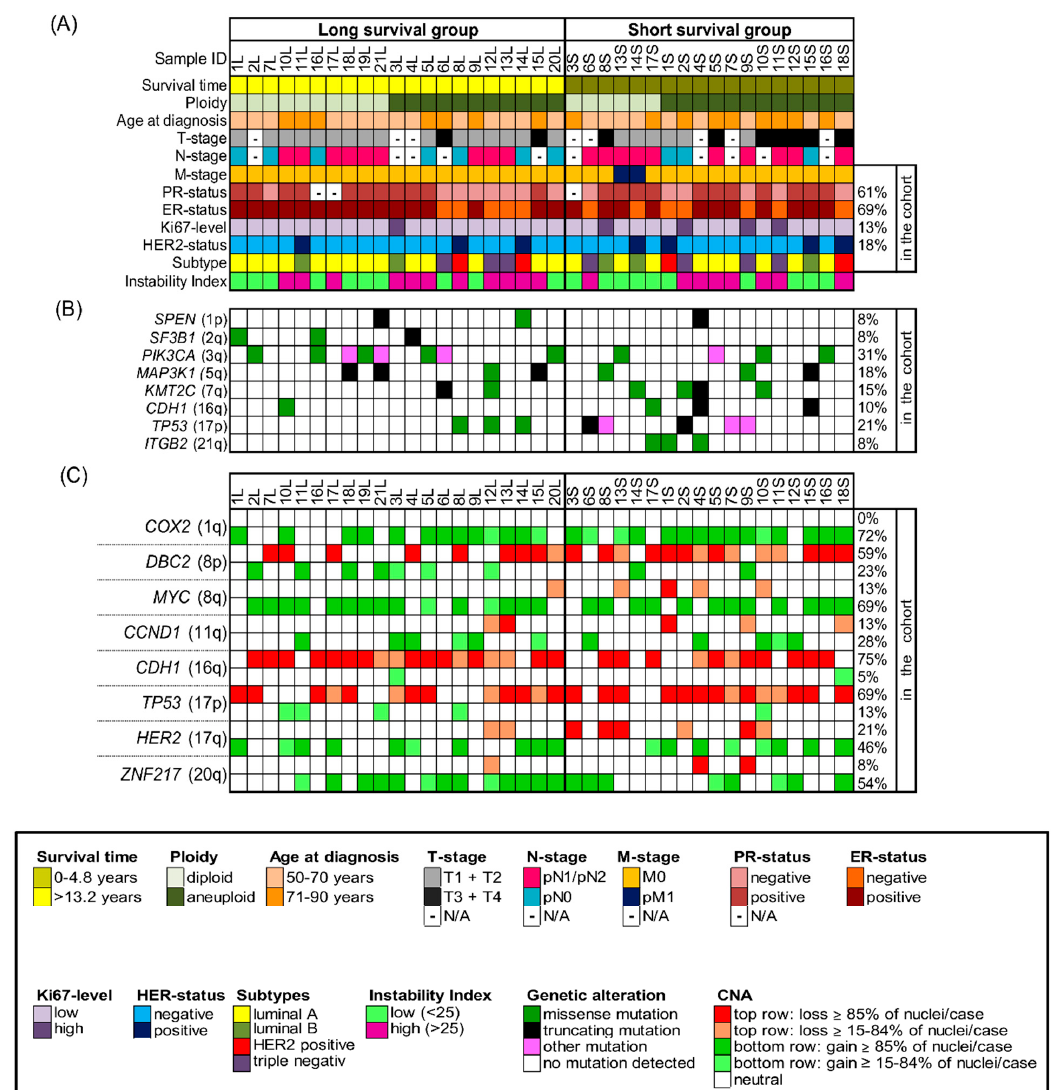
Figure 1. Clinicopathological features, NGS-mutation-analysis and miFISH results presented for the entire cohort ( n = 39) with corresponding color codes sorted by ploidy and separated into the groups of long survival and short survival after diagnosis. ( A ) Summary of the clinicopathological features (rows) of the short and long survival groups, additionally sorted by ploidy and plotted per individual sample (columns). ( B ) Extraction of mutation analysis of 563 breast-cancer associated genes (OncoVar) by NGS. Distribution of mutations sorted by chromosomal location that affected genes in at least three samples. The color code indicates the type of mutation. PIK3CA , TP53 and MAP3K1 were the most-frequently mutated genes. ( C ) Copy number alterations of 8 breast cancer-related genes sorted by chromosomal location were identified by miFISH and are plotted vertically per individual sample (columns). Green color indicates a gain, red color a loss. We chose dark hues if the majority ( ≥ 85%) of all nuclei showed a gain/loss and light hues if 15–84% showed a gain/loss. The oncogenes COX2 and MYC and the tumor suppressor genes CDH1 and TP53 were most-frequently subject to copy number